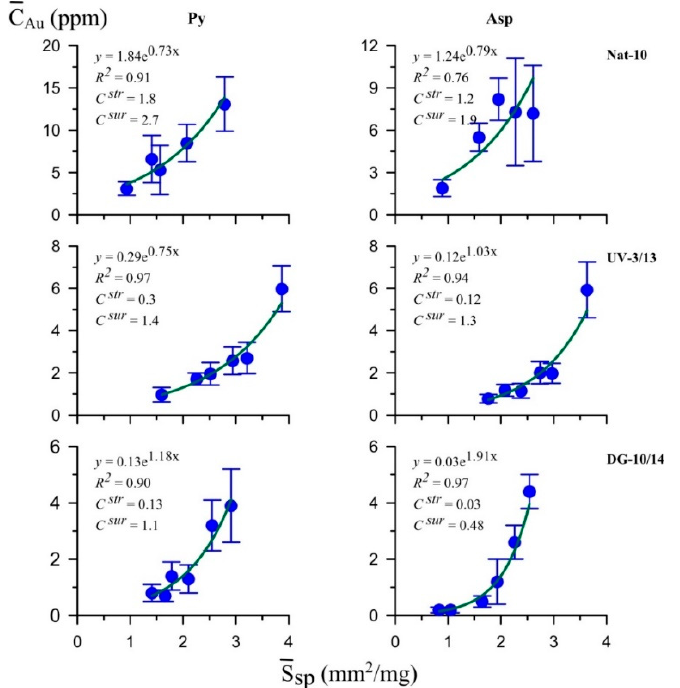
Figure 5. Dependence of the average concentration of evenly distributed Au in pyrite (Py) and arsenopyrite (Asp) on the specific surface area of an average crystal in size fraction. The expressions for approximate curves and concentrations of structurally and superficially bound modes are shown (see Table S1 in the Supplementary Materials for details).